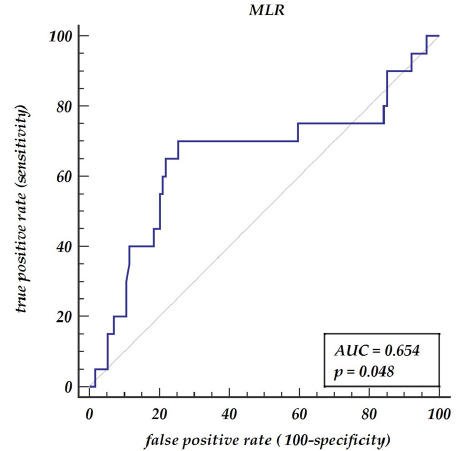
Figure 1. Receiver operator characteristic curve for monocyte to lymphocyte ratio. Abbreviations: AUC—area under the curve, MLR—monocyte to lymphocyte ratio.